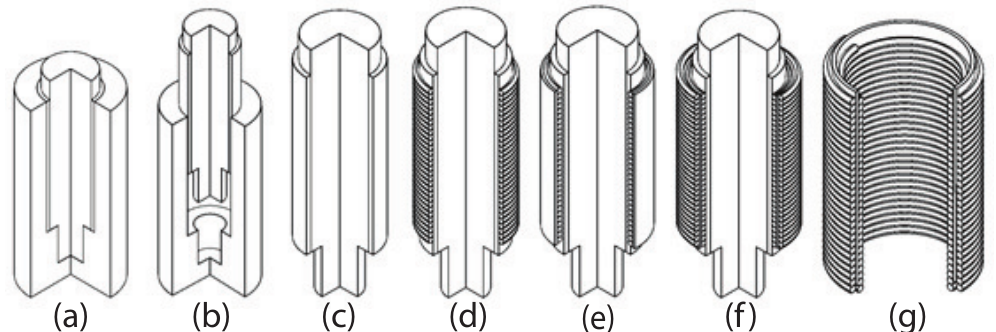
Figure 4. Fabrication process of proposed dual-spring cylindrical DEA: ( a ) cylindrical mold is first filled with Gypsum; ( b , c ) Gypsum axle is then demolded and stripped out from barrel; ( d ) first layer of compliant electrode is created by coiling copper wire around axle; ( e ) thin VHB 4905 film folded to cover cylindrical copper springs; ( f ) second layer of compliant electrode is created by coiling copper wire around outer surface of VHB film; ( g ) actuator comprising VHB film sandwiched by copper springs inside and outside is released from